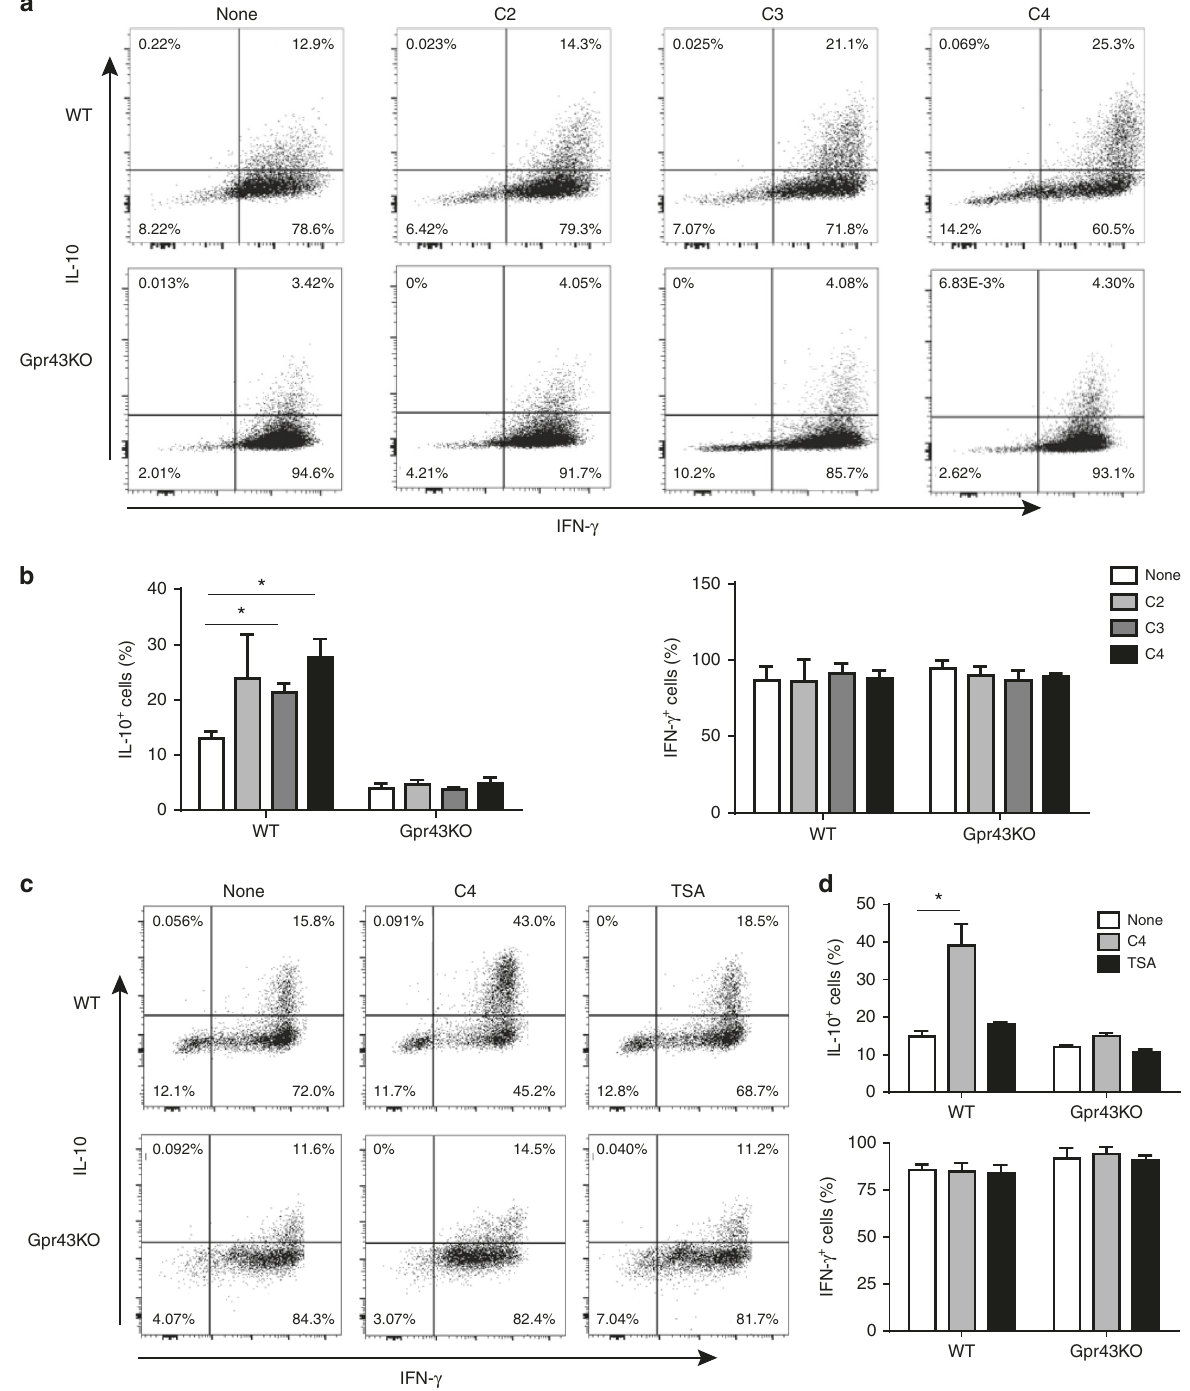
Fig. 2 SCFAs induce IL-10 production of Th1 cells through interaction with GPR43. 1 × 10 6 WT CBir1 (WT) and Gpr43 − / – CBir1 Tg (Gpr43 KO) Th1 cells ( n = 3/group) were cultured with irradiated APC and CBir1 peptide in the presence or absence of acetate (C2, 10 mM), propionate (C3, 0.5 mM), and butyrate (C4, 0.5 mM) for 5 days. a , b The expression of IL-10 and IFN- γ was examined by fl ow cytometry analysis. c , d 1 × 10 6 CBir1 Th1 cells were stimulated with C4 and HDAC inhibitor TSA (10 nM), respectively, for 5 days. The expression of IL-10 and IFN- γ was examined by fl ow cytometry analysis. Results are shown as mean ± SD of triplicates from one representative of three experiments performed. * p < 0.05 one-way ANOVA